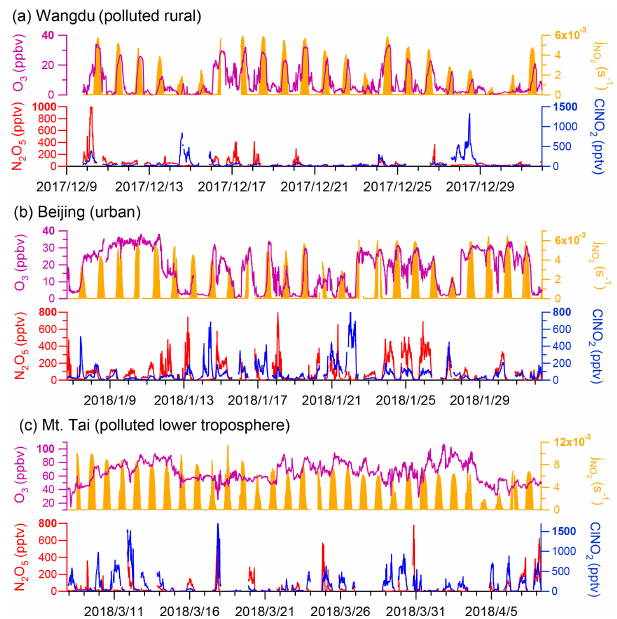
Figure 1. Overall observations of N 2 O 5 , ClNO 2 , and related species at the (a) Wangdu, (b) Beijing, and (c) Mt. Tai sites.